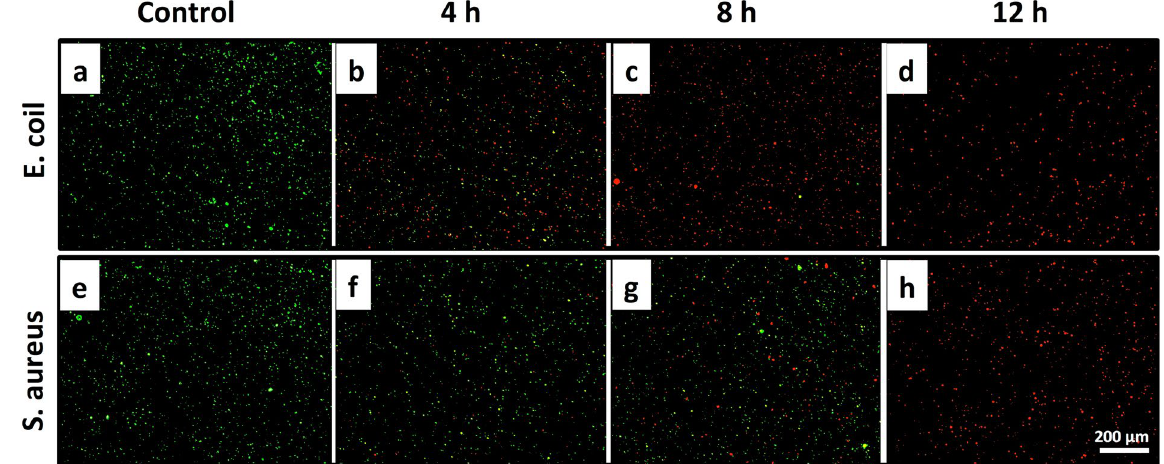
Figure 8. Fluorescence micrograph of E. coli and S. aureus treated with or without CSS-Ag NPs. After being treated with CSS-Ag NPs for 4 h ( b,f ), 8 h ( c,g ), and 12 h ( d,h ), respectively. The untreated E. coli and S. aureus served as a control group ( a,e ). The scale bar is 200 μ m.